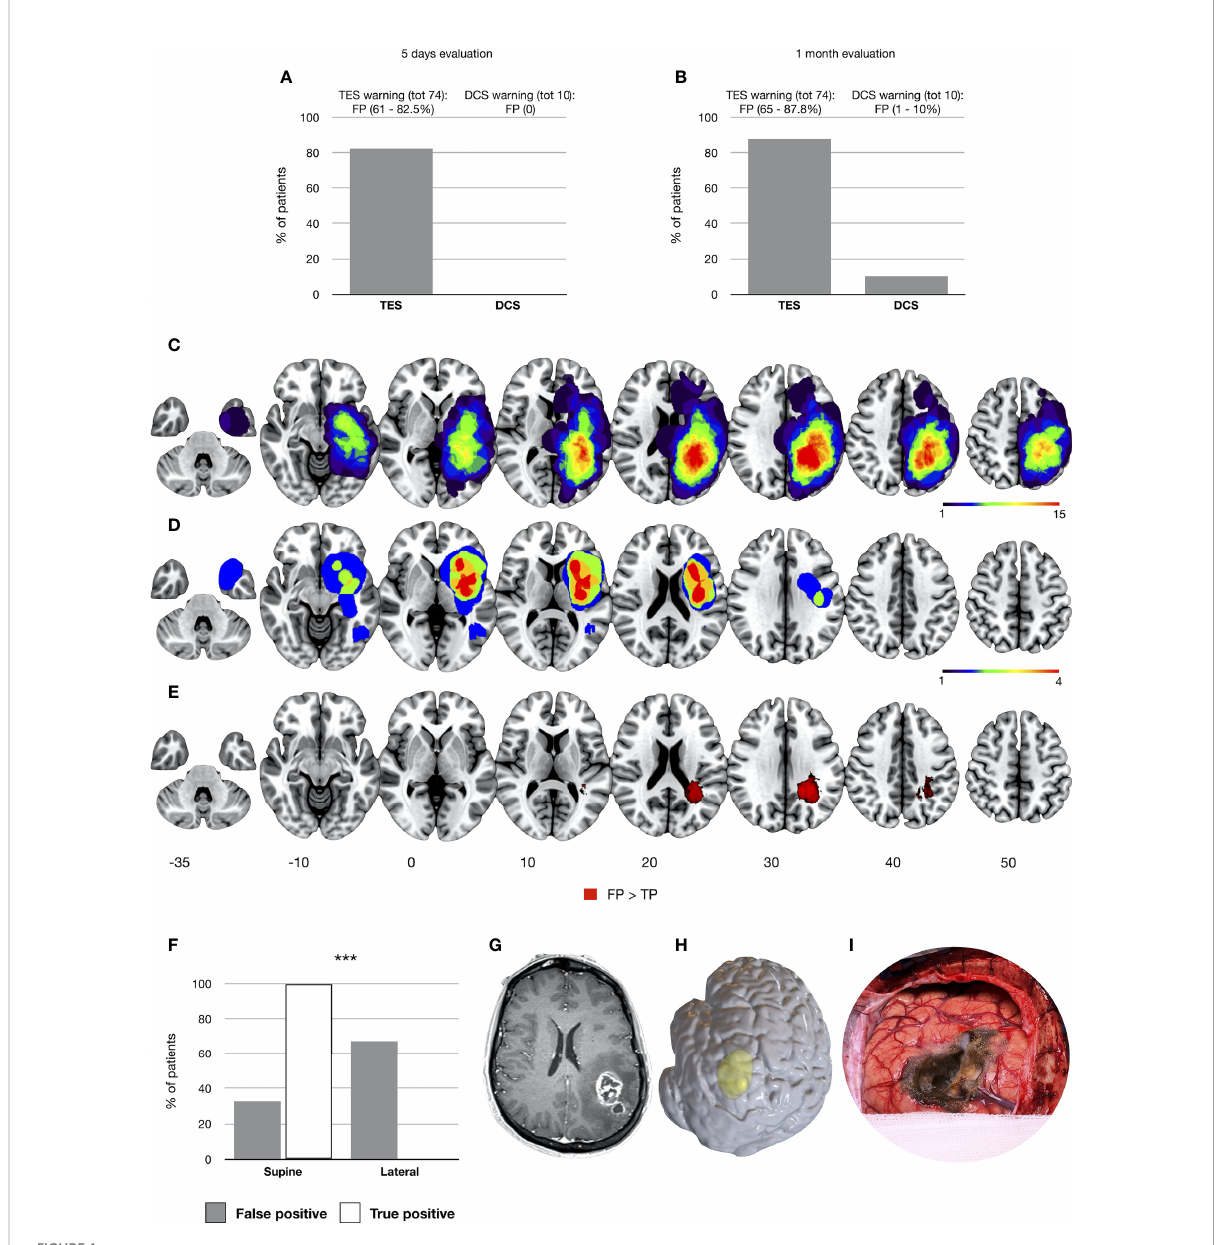
FIGURE 1 Occurrence of false-positive results for TES and DCS considering the 5-day (A) and 1-month follow-up (B) . Tumor volumes of patients with TES FP and TP results (1-month follow-up) are overlapped respectively in (C, D) . The signi fi cant cluster predicting the occurrence of TES FP results is displayed in (E) (TFCE, p = 0.05). All tumor volumes, normalized to the MNI template, are visualized on left hemisphere axial slices. In (F) the distribution of supine and lateral craniotomies is reported between the FP and TP patients. Finally, in (G) (left panel, postcontrast T1-weighted images), a case of a high-grade glioma located in the left parietal lobe is presented in which a TES intraoperative MEP amplitude decreased but preserved postoperative motor status was recorded. In (H) , a 3D render of the preoperative T1 is presented to show the lateral head